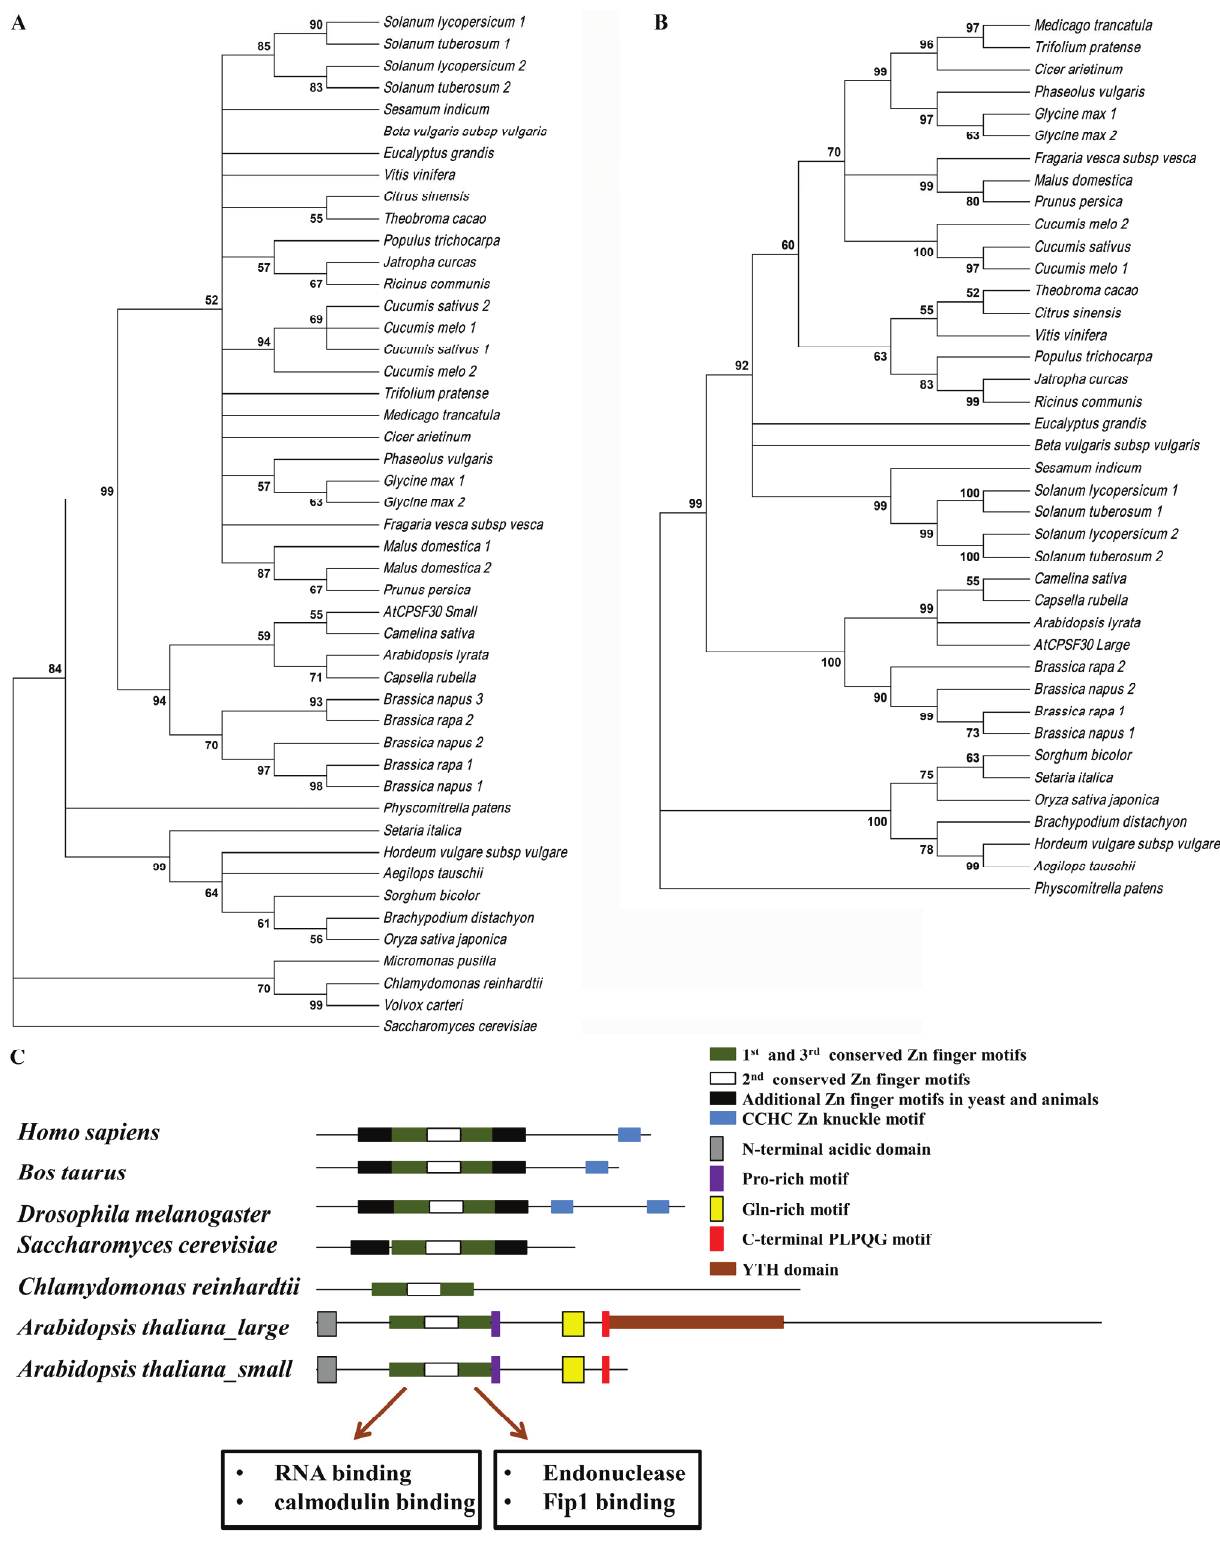
Figure 2. Amino acid sequence alignment and domain architecture analysis of CPSF30. ( A ) Tree showing the results of alignments of the small CPSF30 polypeptide (corresponding to the 28 kD polypeptide encoded by the Arabidopsis At1g30460 locus) from diverse plant species, algae, and yeast. ( B ) Tree showing the results of alignments of the large CPSF30 polypeptides from diverse plant species (analogous polypeptides are not present in